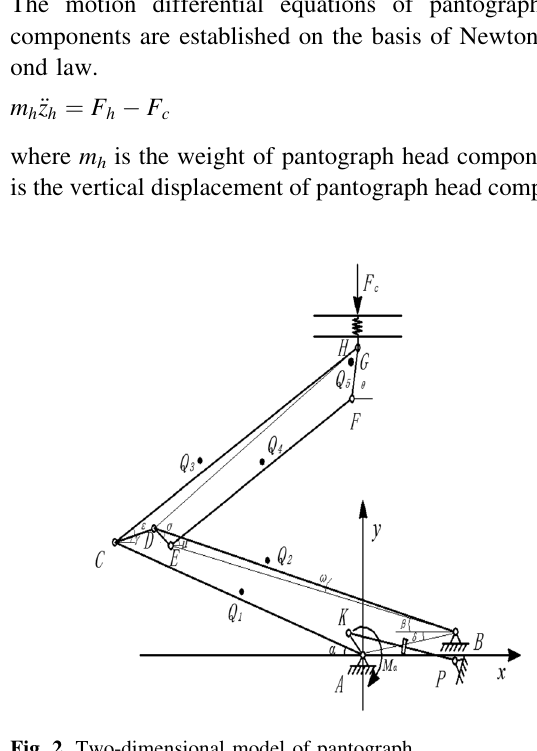
Fig. 2 Two-dimensional model of